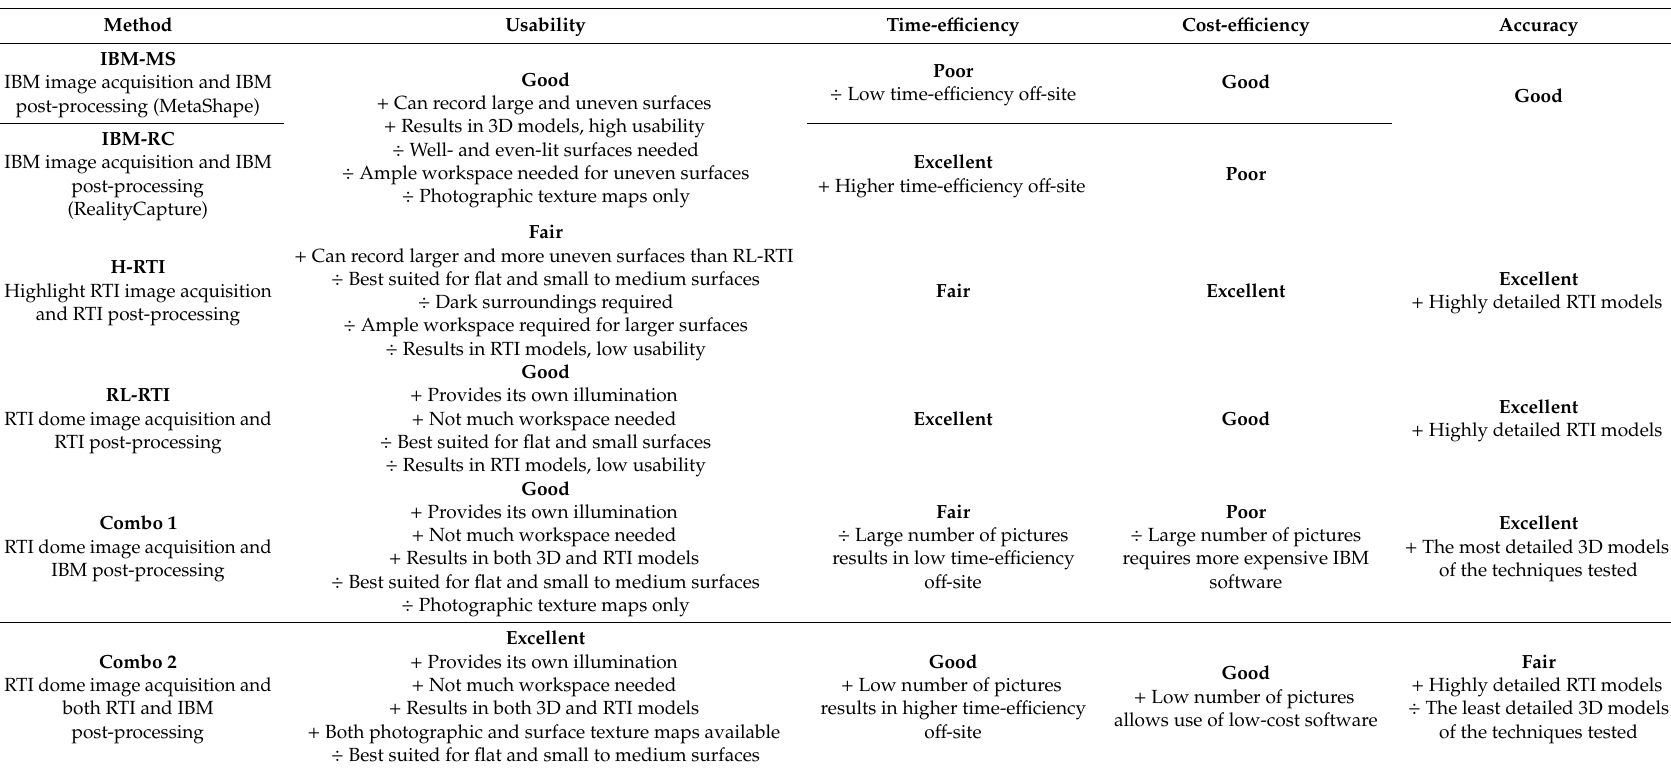
Table 5. The methods compared. For further elaborations of the evaluations, see the corresponding sections in the Results